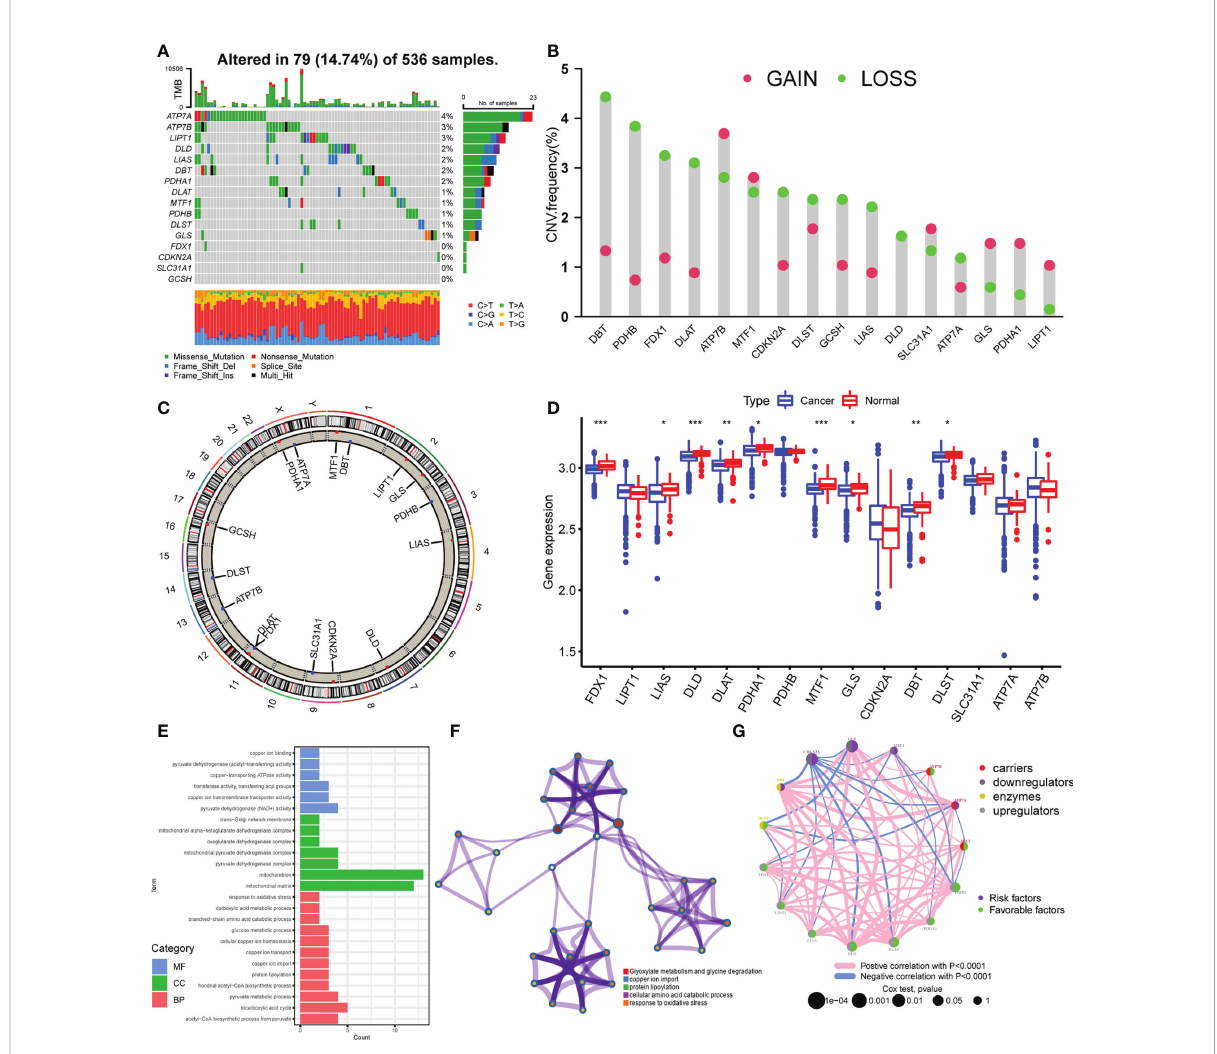
FIGURE 1 Landscape of genetic variation of cuproptosis regulators in colorectal cancer. (A) The mutation frequency of 16 cuproptosis regulators in 536 samples from TCGA-COAD/READ. (B) The CNV variation frequency of 16 cuproptosis regulators in TCGA-COAD/READ. (C) The location diagram of CNV of 16 cuproptosis regulators on 23 chromosomes. (D) The expression of 16 cuproptosis regulators in cancer and normal samples of TCGA-COAD/READ. (E) Go analysis results of 16 cuproptosis regulators (F) . Metascape analysis of 16 cuproptosis regulators (G) . The overall landscape of the interaction between cuproptosis regulators and the prognostic signi fi cance of the regulators in colorectal cancer patients. *P <0.05; **P <0.01; ***P